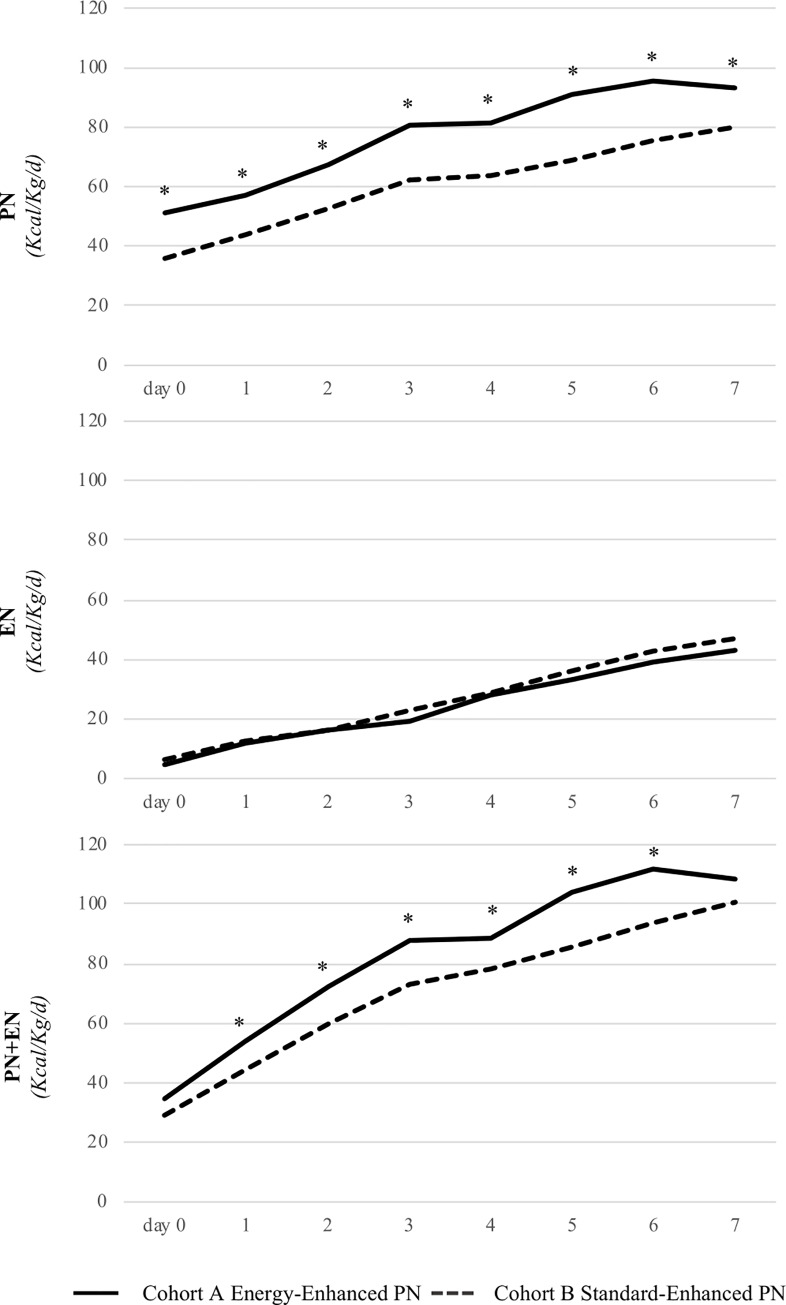
Energy intake included calories coming from protein; PN: parenteral nutrition; EN: enteral nutrition; * Cohort A vs Cohort B p<0.05.